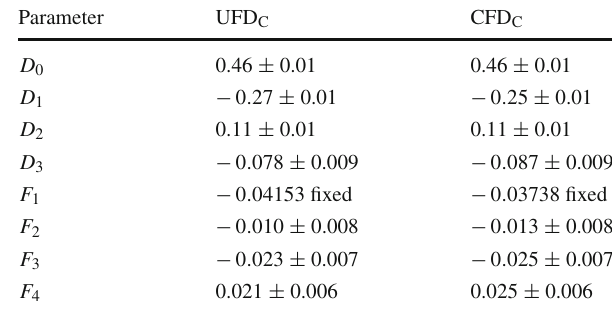
Table 3 Parameters of φ 0